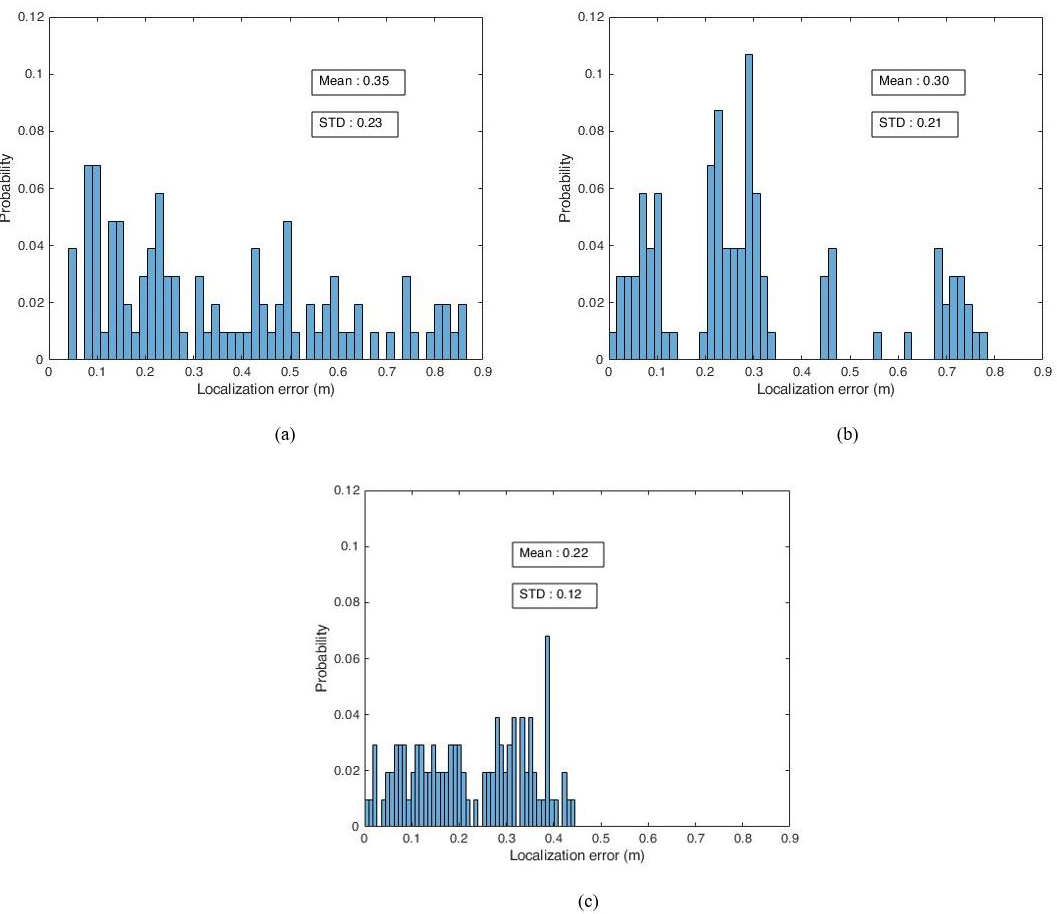
Figure 12. Probability distribution of the localization error for linear motion. ( a ) PDR+Wi-Fi Table 2. Performance of different sensor fusion frameworks for path 1 rectangular